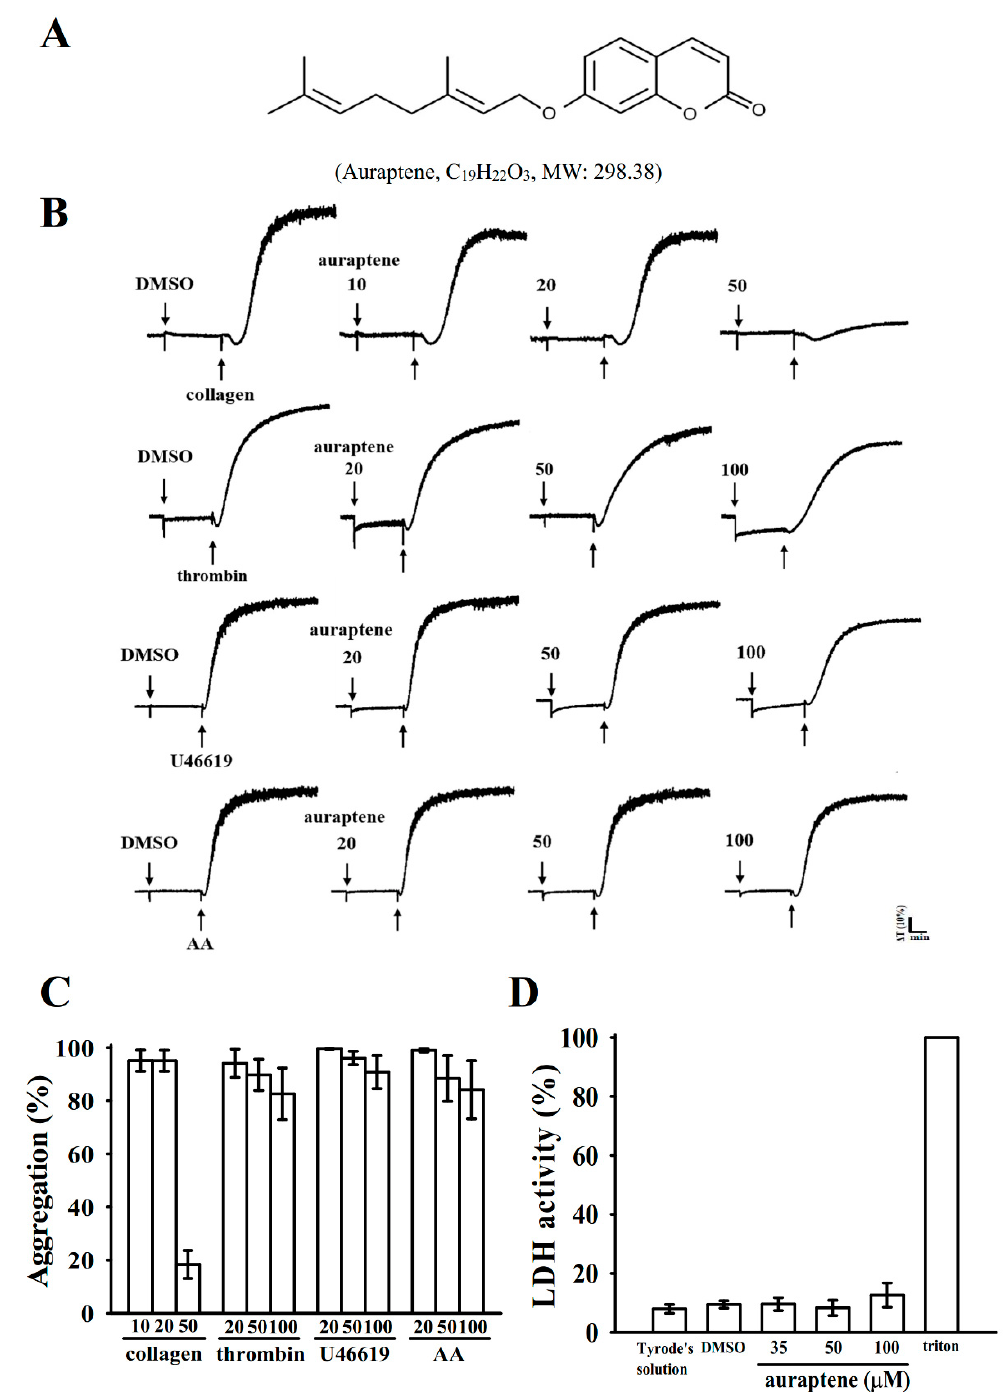
Figure 1. Auraptene inhibits agonists-induced platelet aggregation without causing cytotoxicity. Washed human platelets (3.6 × 10 8 cells/mL) were preincubated with ( B ) a solvent control (0.1% dimethyl sulfoxide (DMSO)) or auraptene (10–100 µ M) ( A , chemical structure) and subsequently treated with 1 µ g / mL collagen, 0.01 U / mL thrombin, 1 µ M U46619, or 60 µ M arachidonic acid (AA) to trigger platelet aggregation. For the study of cytotoxicity, platelets were preincubated with 0.1% DMSO or auraptene (35, 50, and 100 µ M) for 20 min, and a 10- µ L aliquot of the supernatant was deposited on the Fuji Dri-Chem slide LDH-PIII. Data ( C , D ) are presented as means ± SEM ( n = 4).